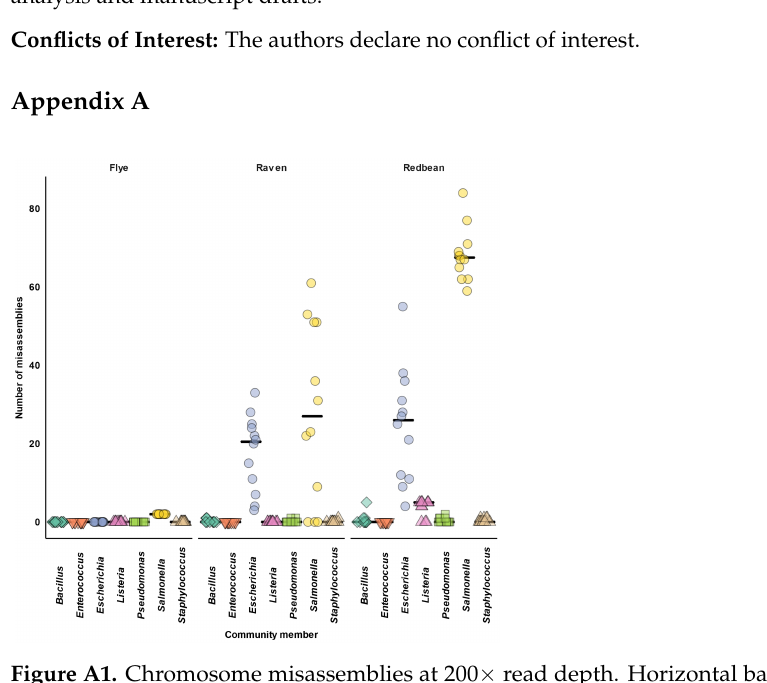
Figure A1. Chromosome misassemblies at 200 × read depth. Horizontal bars indicate the median value across replicate